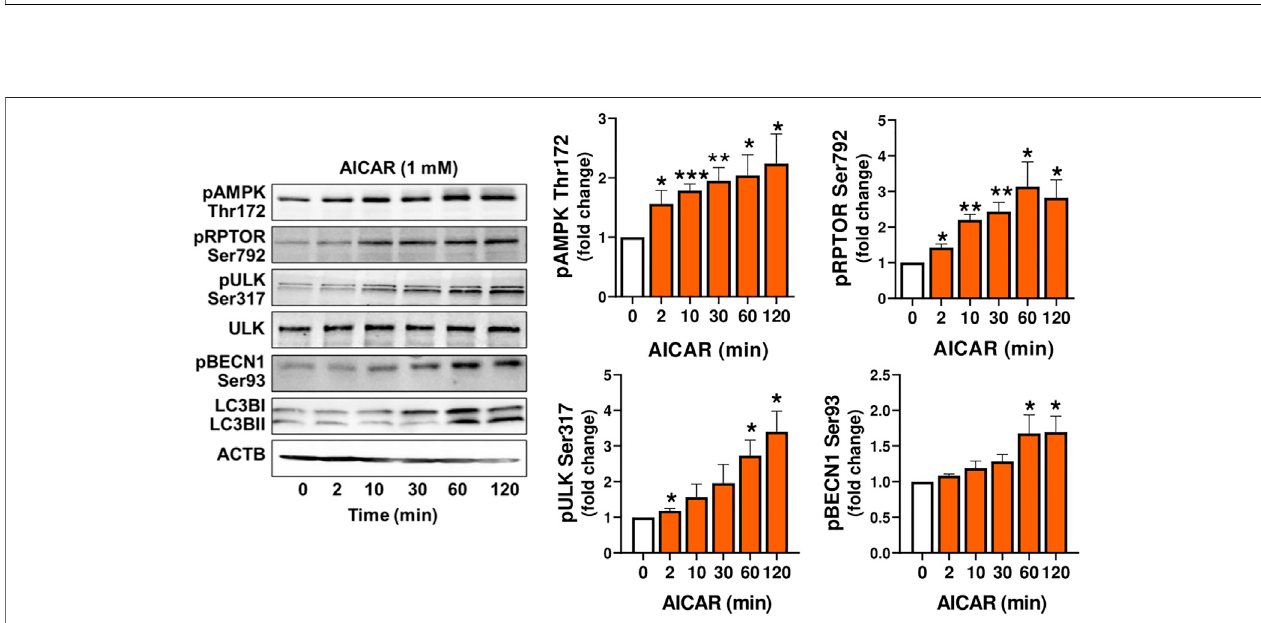
FIGURE 2 | The AMPK activator AICAR triggers phosphorylation of proteins involved in MTOR inhibition and autophagy initiation. Primary cultures of bovine small luteal cells were treated with the AMPK activator AICAR (1 mM), for 2 – 120 min. Representative immunoblots and bar graphs showing phosphorylation of AMPK α (Thr172), the AMPK substrates RPTOR (Ser792), ULK1 (Ser317) and BECN1 (Ser93), and total ULK1 and LC3B. Data are shown as a fold change and presented as means ± SEM from three-four separate experiments. Data were normalized to β -actin (ACTB). Statistical analysis was performed using one-way ANOVA test with post hoc Bonferroni test. *, **, *** as p < 0.05, p < 0.01 and p < 0.001.